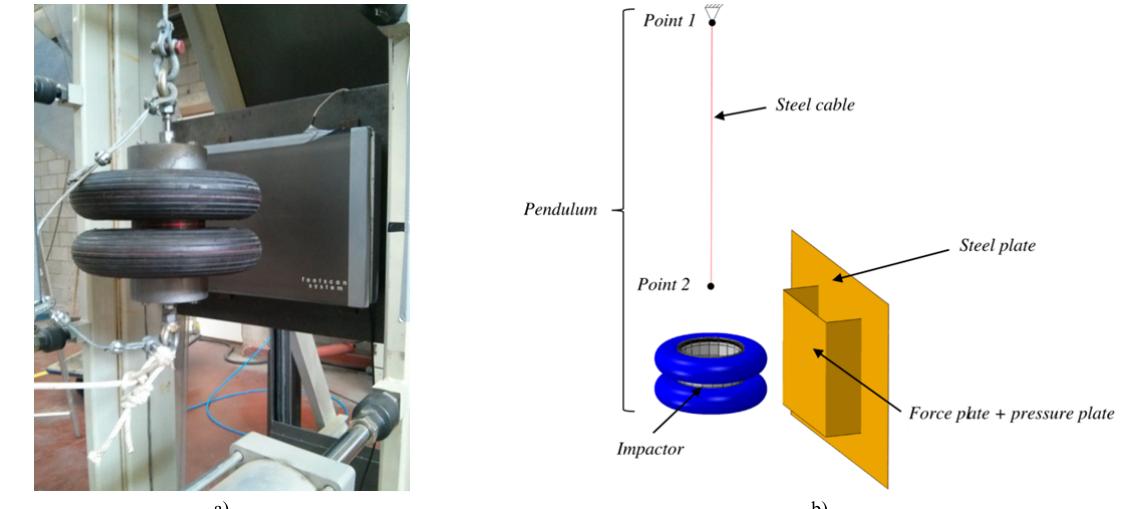
Fig. 8 Twin-tyre pendulum impact setup with force and pressure plate: a) Photograph of experimental setup and b) FE model